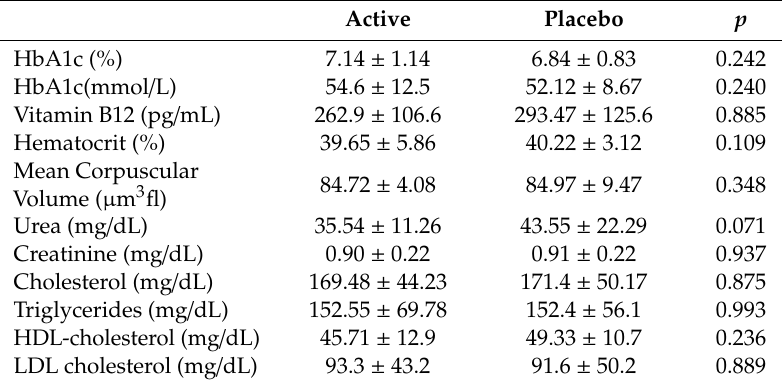
Table 2. Laboratory measurements at the baseline for both groups.